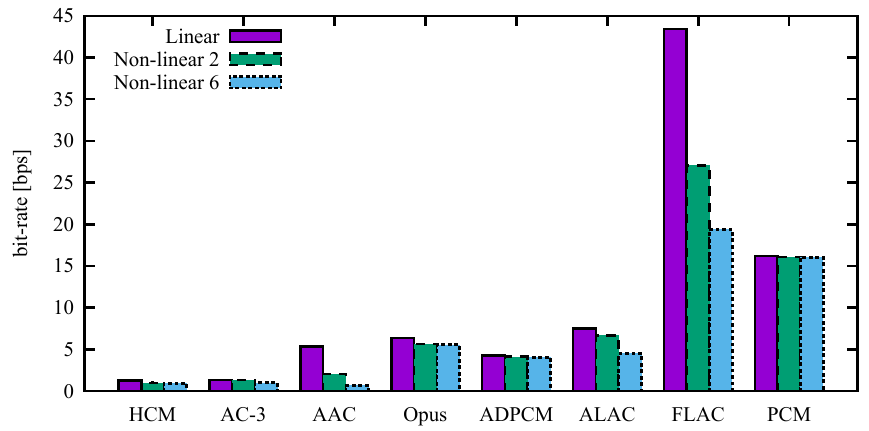
Figure 5. Average bit rates for the peak signal-to-noise ratio (PSNR) as close as possible to 50 dB for three testing datasets.